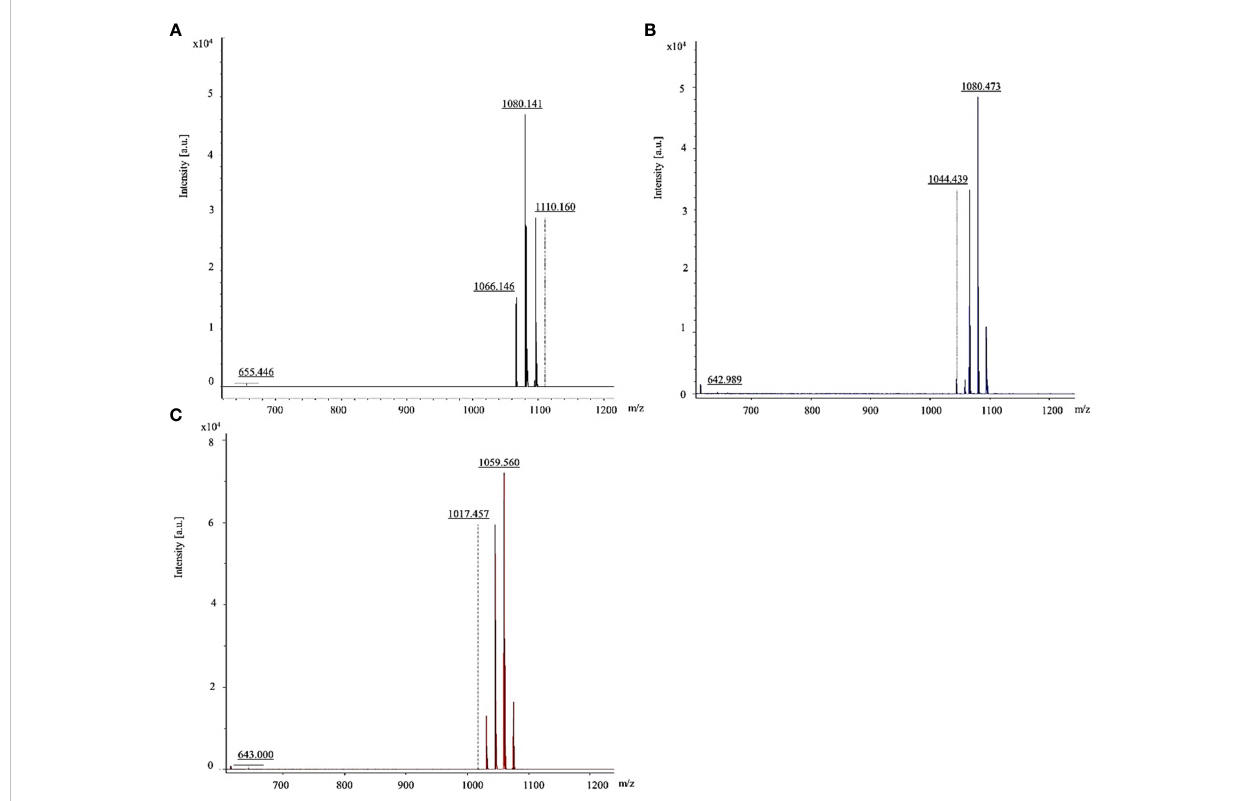
FIGURE 4 MALDI-TOF/TOF mass spectra of lipopeptides detected the range of 600 – 1,200 m / z . (A) Iturin A and surfactin in biosurfactant produced by Bacillus vallismortis assigned. (B) Iturin A standard. (C) Surfactin